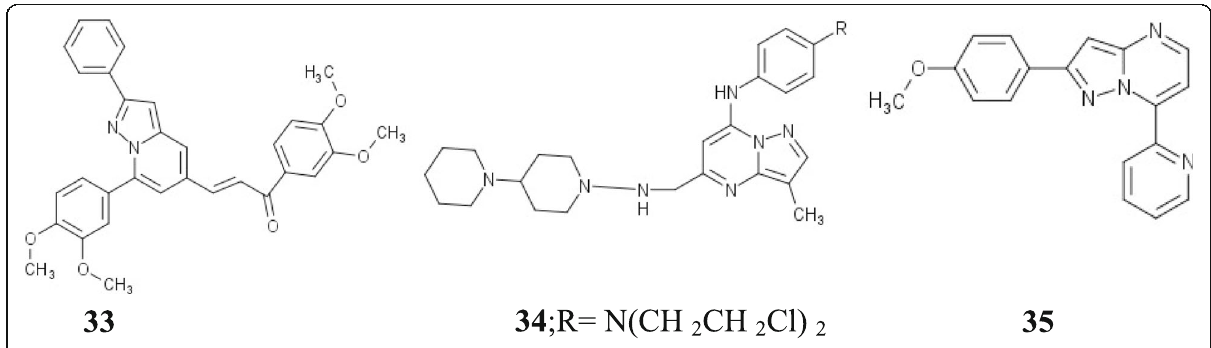
Fig. 15 Chemical structures of pyrazolo [1, 5-a]